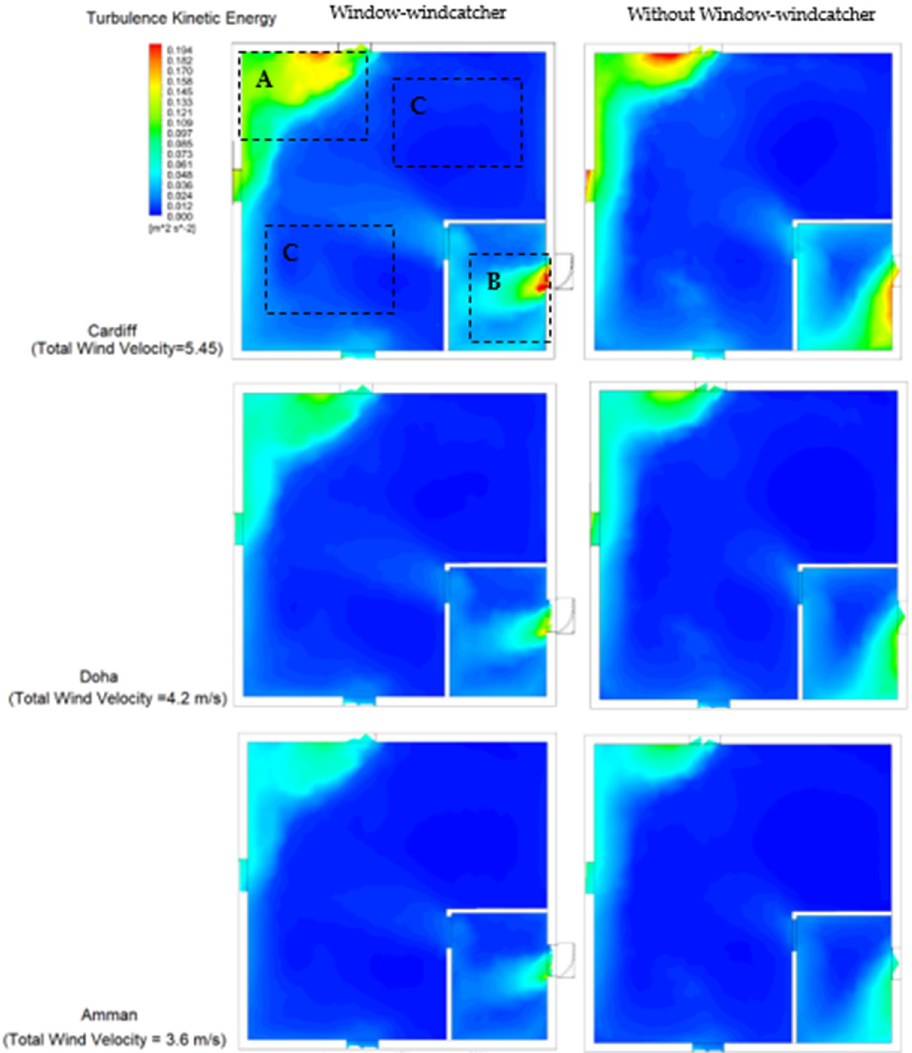
Figure 9. Turbulence kinetic energy profile at the 1 m interior plane (A and B: High-turbulence region, C: Low-turbulence region).